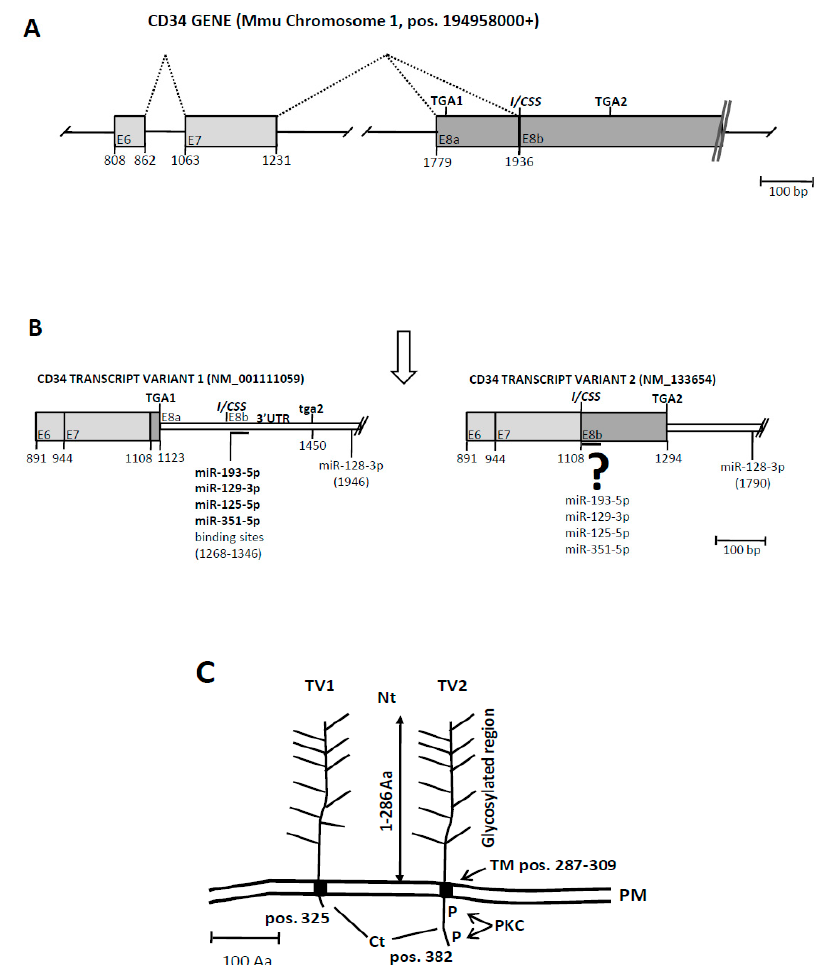
Figure 4. Structure and expression of the murine Cd34 genetic loci and its interaction with miR-125 and other miRNAs. ( A ) Diagram of the murine Cd34 gene. Exons are represented by colored boxes, intergenic regions by solid lines and splicing events by doted lines. Shown are exons 6,7 and 8 only. Former exon X is here shown as part “a” of exon 8 (see text). Shown are also the two stop codons (TGA1, TGA2) at exon 8, as well as the internal/cryptic splice site ( I/CSS ) at the virtual juncture of exon 8a/b. Numbering refers to the position in the NCBI Reference Sequence: NC_000067.6. Drawn to scale (1cm = 100bp). ( B ) Diagram showing the two Cd34 transcripts originated by the internal/cryptic splice event at exon 8. Coding regions are expressed as colored boxes while the 3’UTRs are shown as white bars. Also shown are the two stop codons (the active one in capital letters), the internal/cryptic splice site and the miRNA binding sites predicted by the Targetscanmouse at the 3’UTR of Cd34 transcript variant 1. Binding sites at the equivalent positions at the coding region of transcript variant 2 are shown under the question mark. Numbering refers to the Genbank accession numbers of the transcripts. Drawn to scale (1cm = 100bp). Ensembl code for Cd34 -TV1: ENSMUST00000110815. Ensembl code for Cd34 -TV2: ENSMUST00000016638. ( C ) Diagram showing the two different proteins encoded by CD34 transcripts variant 1 and 2 (TV1, TV2). Shown are the glycosylated Nterminal extracellular domain (Nt), the transmembrane domain (TM) and the different Cterminal domains (Ct) of both protein isoforms. Protein kinase C phosphorylation sites are labelled in TV2. Numbering refers to the Genbank accession numbers of the transcripts (see B). Drawn to scale (1cm = 100Aa). PM stands for plasma